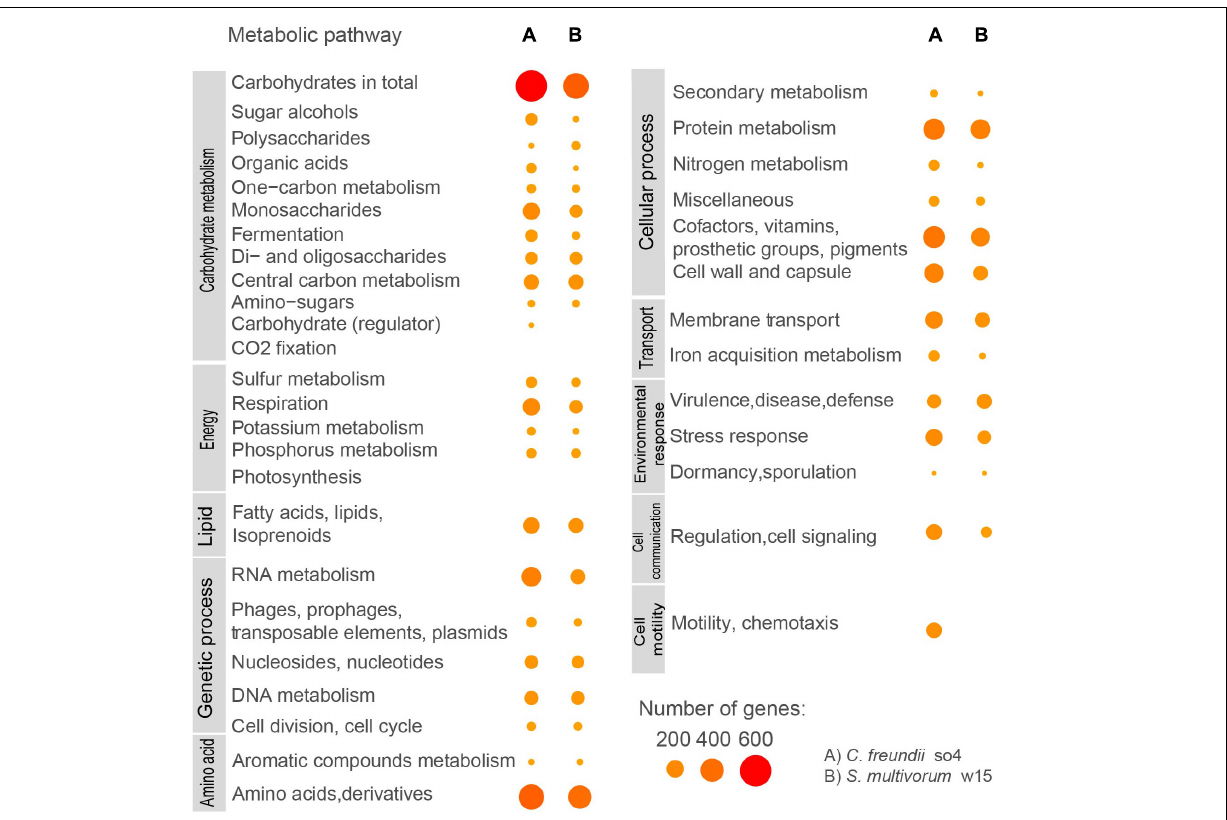
FIGURE 2 | Predicted functional subsystems in C. freundii so4 and S. multivorum w15, based on RAST results and KEGG assignments. Sizes and colors of circles indicate numbers of genes assigned to each function.